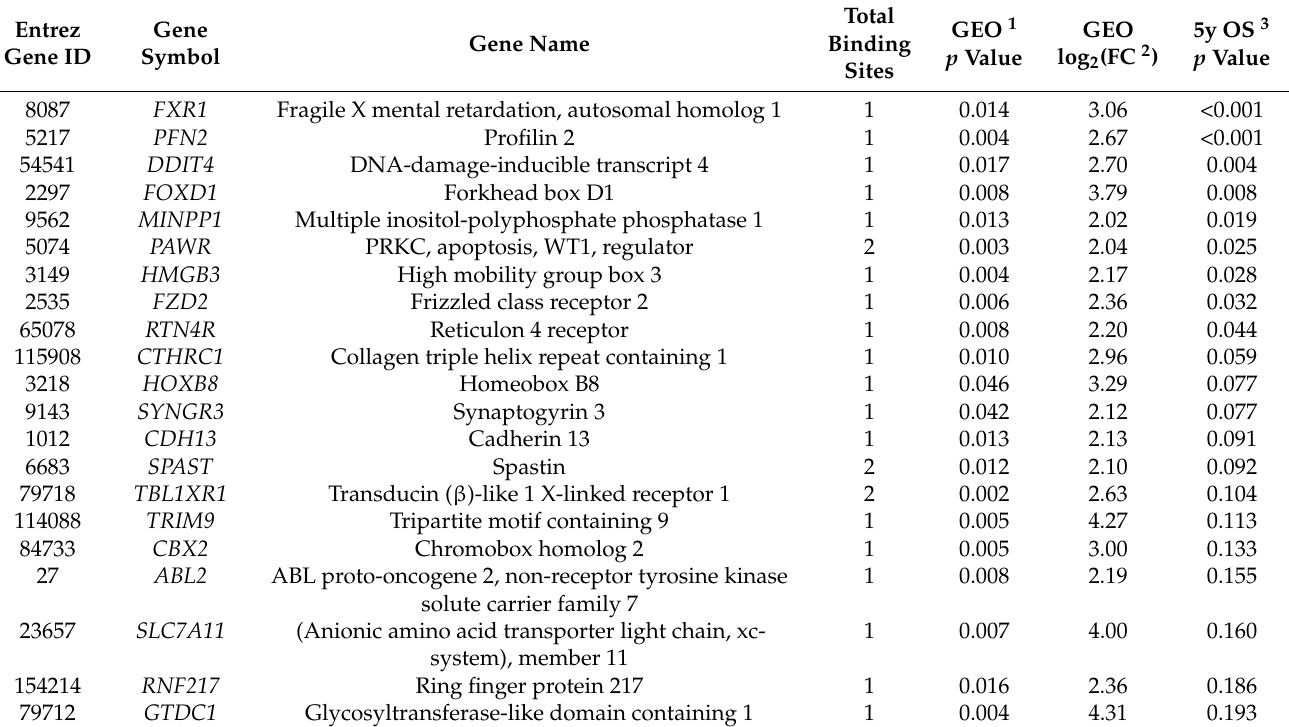
Table 1. Candidate target genes regulated by miR-30-5p .